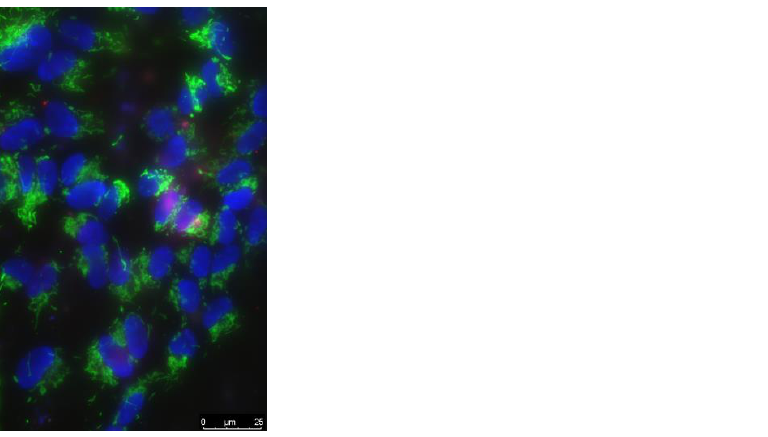
Figure 1. The example of photomicrograph of a cell culture. Green staining corresponds to mitochondria (used to evaluate shape and size of cells); blue staining indicates nuclei of viable. Purple staining indicates of nuclei of non-viable cells.